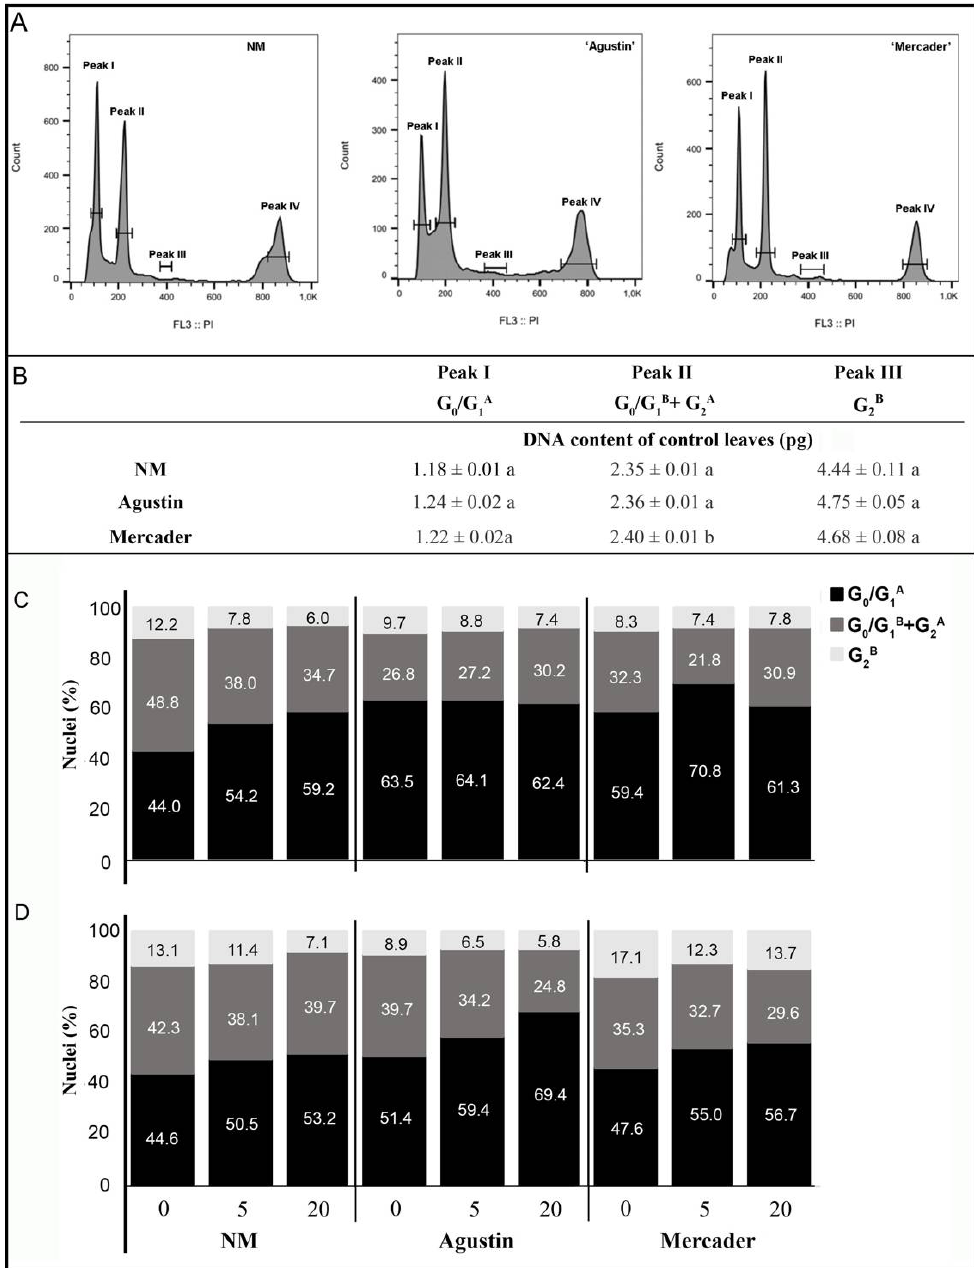
Figure 4. Representative FCM histograms ( A ), DNA content (pg) ( B ) from control leaves and percentage of nuclei on each FCM peak in leaves ( C ) and roots ( D ) of seedlings from non-mining (NM) and mining areas (Agustin and Mercader); Z. fabago populations exposed to 0, 5 and 20 µM Pb(NO 3 ) 2 for 4 weeks. peak I: G 0 /G 1 phase of the subpopulation A; peak II: G 1 phase of subpopulation B plus G 2 phase of subpopulation A; peak III: G 2 phase of the subpopulation B. Values are calculated using the G 0 /G 1 of the standard Pisum sativum (peak IV). Values are given as mean ± SE. Different letters mean significant differences between populations among the same peak ( p < 0.05). See Table S2 for statistical analysis results of Figure 4C,D.